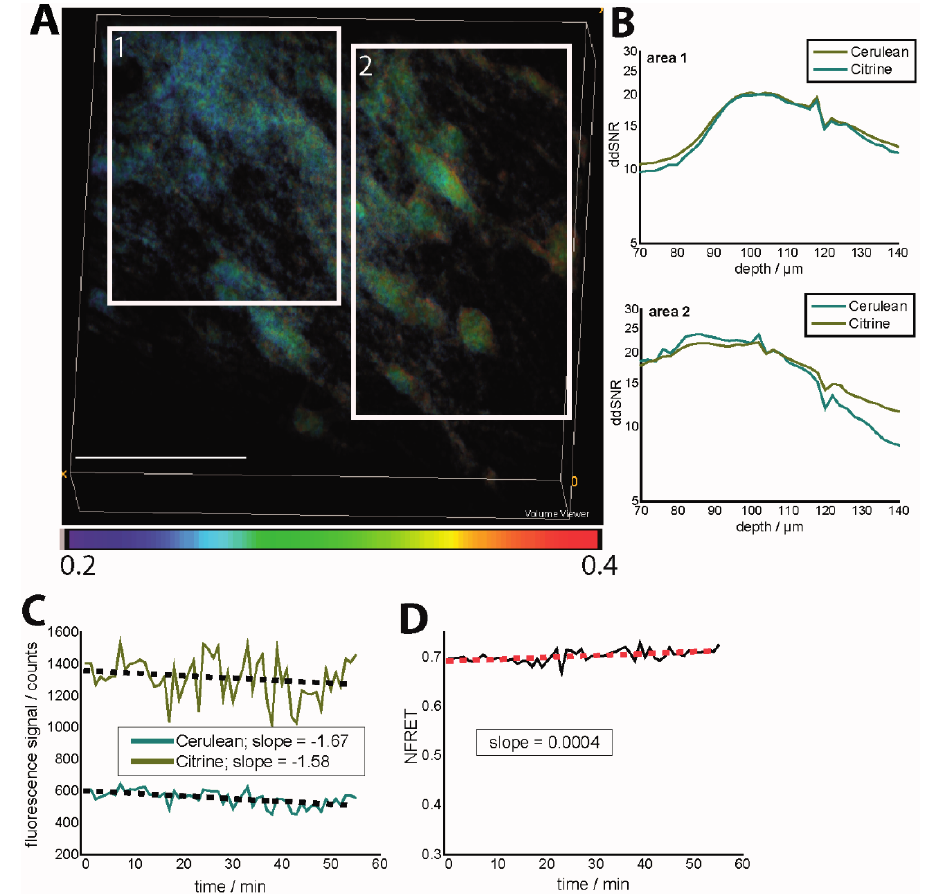
Figure 2. Effects of depth-dependent SNR and photobleaching on the NFRET ratio in the brain stem of CerTN L15 mice (intravital imaging in healthy and untreated tissue). ( A ) NFRET ratio 3D image (300 × 300 × 70 µm³). Regions of different depth-dependent signal-to-noise ratios (ddSNR) show different NFRET ratios although the expected neuronal calcium is expected to be the same; ( B ) Dependence of ddSNR on imaging depth for both Cerulean and Citrine fluorescence signals in the two areas labeled in ( A ); ( C ) Time-dependence of the fluorescence signals of Cerulean and Citrine in Movies S2 and S3 and linear approximation of the photobleaching-ind uced time-decay; ( D ) Time-dependence of the corresponding NFRET ratio (Movie S4) as a consequence of photobleaching. λ exc = 850 nm, λ em (Cerulean) = 475 ± 20 nm, λ em (Citrine) = 535 ± 25 nm. The mean